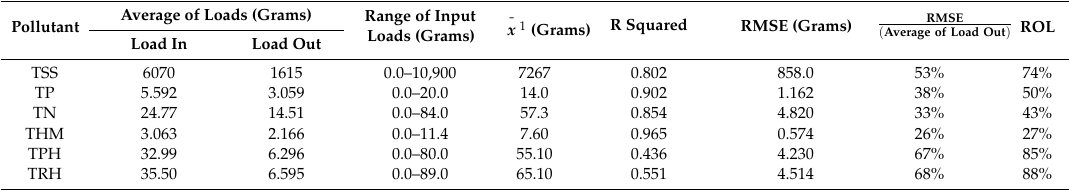
Table 7. Regression of load results.